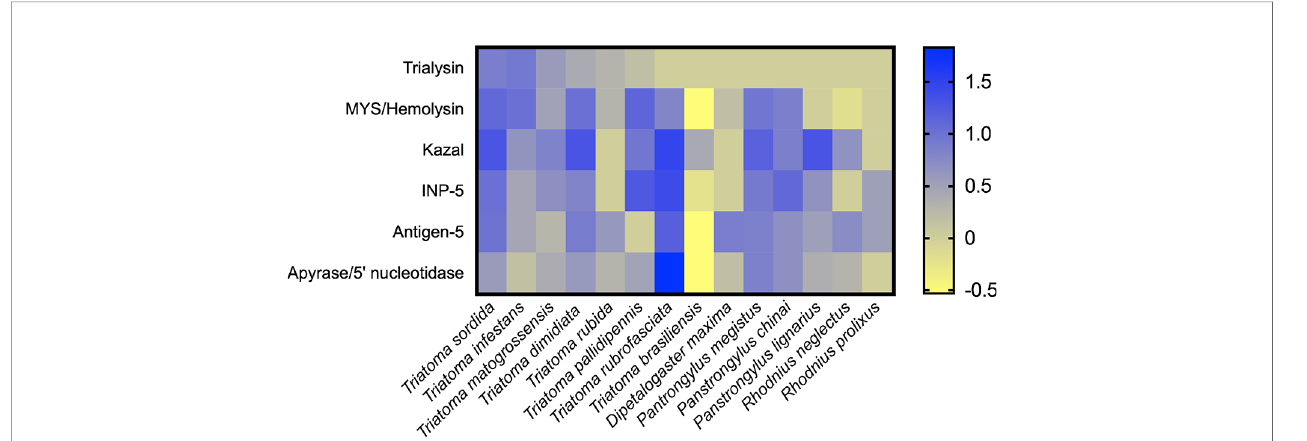
FIGURE 7 | Heat map representing the expression pro fi le of Triatominae salivary CDS. The heatmap shows the normalized CDS count of the main secreted families from Triatominae sialotranscriptomes. The differences among the CDS counts were statistically signi fi cant when compared by a Chi-square test (P < 0.001) (see Supplementary Table 3 ). Rows represent salivary families and columns represent the Triatominae species. The number of CDS frequencies were calculated for each species followed by log10 transformation. Blue-yellow scale: blue represents a high CDS count and yellow low represents low CDS count. The heatmap was created using GraphPad Prism